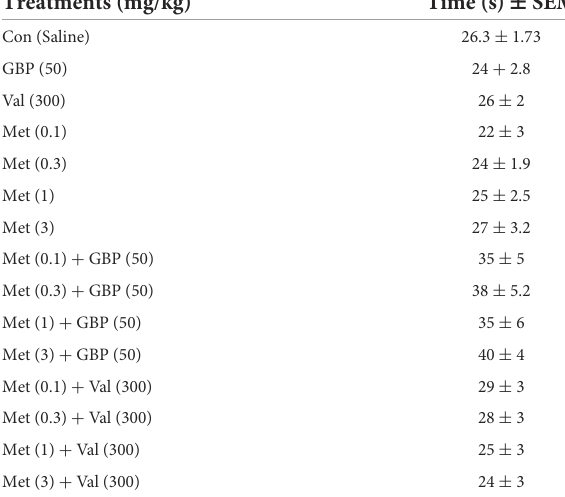
TABLE 2 Effect of methadone, gabapentin, and valproate sodium pretreatment per se , and combined therapy on motor coordination of mice in the chimney